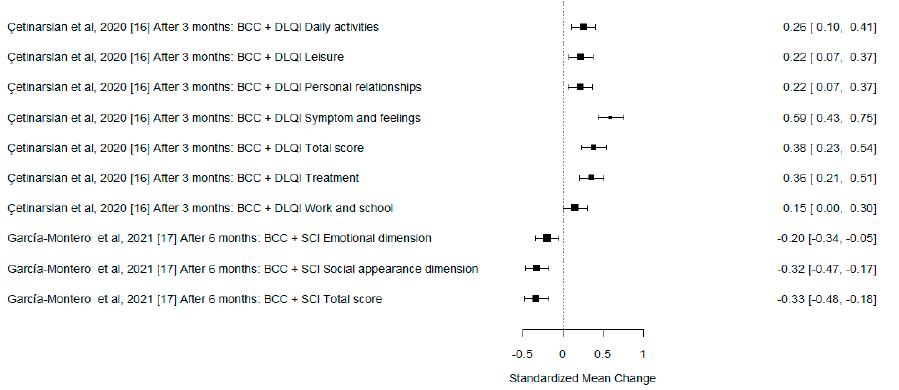
Figure 3. The forest plot for differences in the preoperative and postoperative QoL measures for the BCC group. SMD with 95% CI.